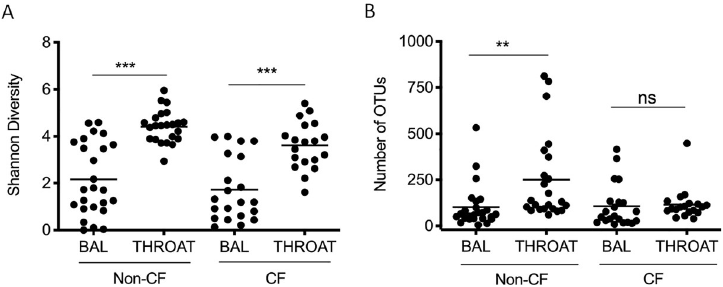
Fig 1. Microbial diversity and species richness of upper and lower airway microbiome in CF children and non-CF disease controls. (A) Shannon indices were calculated to denote microbial diversity and are plotted on the y-axis. Upper airway microbiome was sampled using throat swab, and lower airway microbiome was sampled by bronchioalveolar lavage (BAL). Values were compared using unpaired t-test. (B) The number of OTUs for each sample is plotted on the y-axis. CF = cystic fibrosis. Non-CF denotes non-CF disease controls. ��� p < 0.001, �� p < 0.01, ns = not significant.